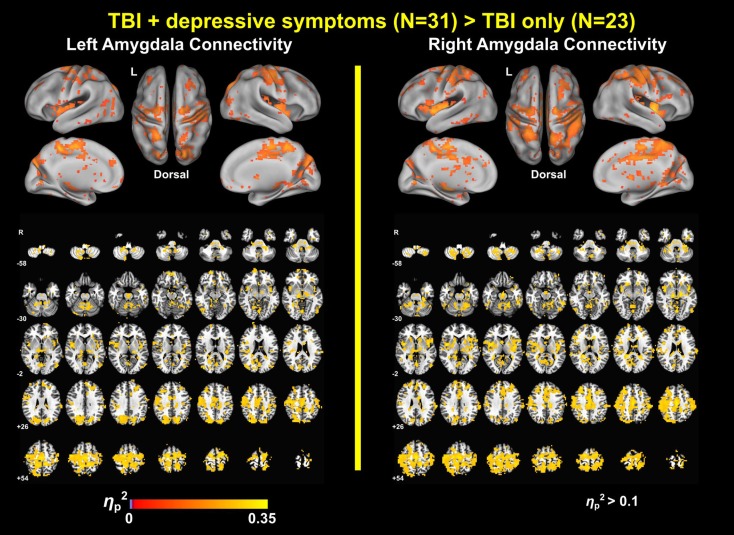
Effect size maps for group differences in amygdala connectivity.